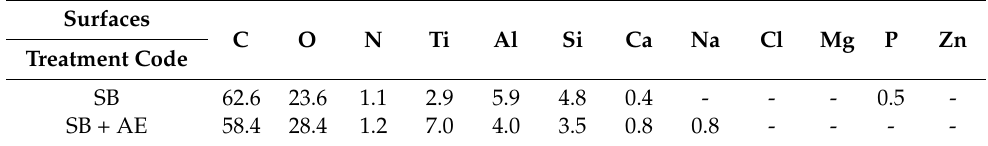
Table 1. Weight percentage of each element detected by XPS on the implant surface. “-” means that the chemical element was not detected.